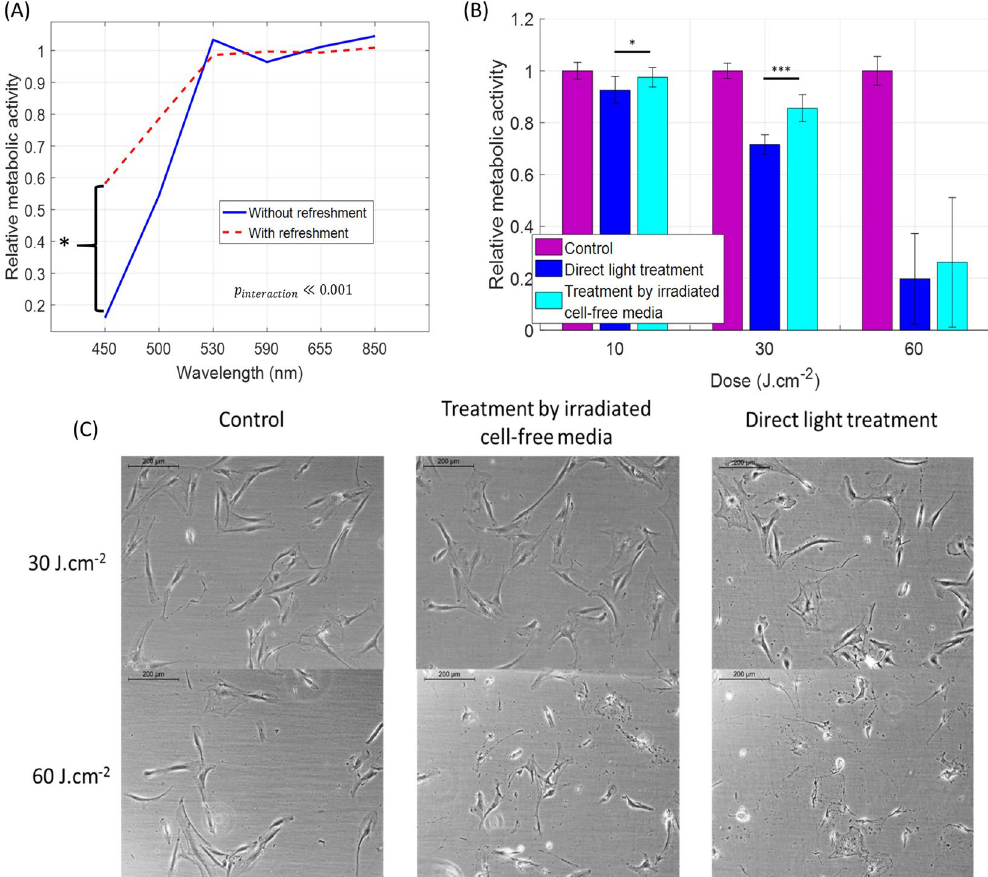
Figure 6. The inhibitory effect of blue light (450 nm) on the metabolic activity of human dermal fibroblasts is mediated by components present in the culture medium. ( A ) Relative metabolic activity of fibroblasts after light treatment as a function of the wavelength and the treatment regime (one or more consecutive irradiations) and protocol (direct light exposure or contact with pre-exposed culture medium). Metabolic activity after treatment was normalized to that of the control sample. Number of donors N = 3, number of technical replicates n = 3, data on papillary and reticular pools were merged together. The significance of the interaction between wavelength and treatment method was evaluated with ANOVA (p ≪ 0.001). ( B ) Relative metabolic activity of the fibroblasts after light treatment for two treatment protocols: direct light exposure (blue) and pre-exposure of DMEM alone followed by pouring on top of the cells (cyan). ( C ) Phase-contrast pictures of human reticular fibroblasts 24 h after the last treatment, in control group, treated group (30 J.cm − 2 and 60 J.cm − 2 ) and treated by irradiated cell-free media. An irradiance of 50 mW.cm − 2 was used. Statistical analysis was evaluated using student t-tests between the control group and treated group (N = 3, reticular and 3 replicates), with following thresholds * p < 0.05, ** p < 0.01, *** p < 0.001. The control group is has an average relative metabolic activity of